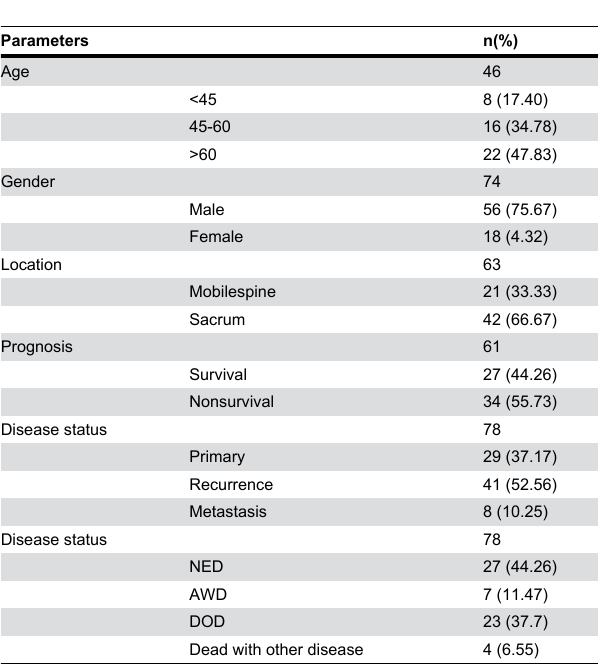
Table 1. The clinical parameters of chordoma tissue